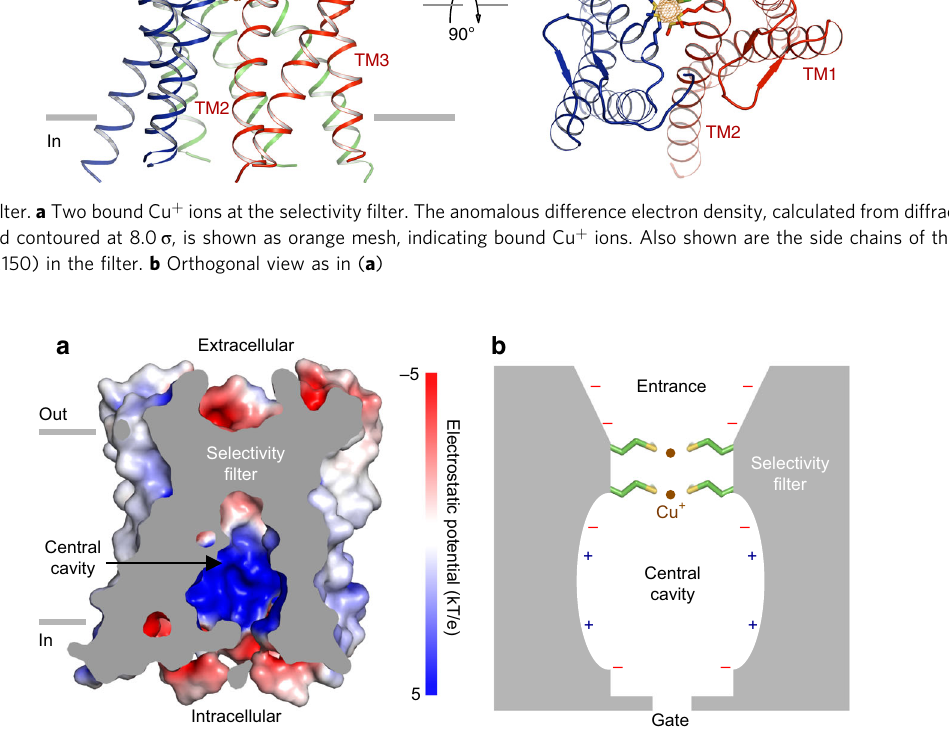
Fig. 5 Cu + permeation. a Cross-section view showing surface of the sCtr1 ion conduction pore colored by electrostatic potential (red, − 5 kT/e; white, neutral; blue, + 5 kT/e), with the relationship of the pore relative to the cell membrane shown. b Proposed mechanism of Ctr1 Cu + ion selectivity and permeation. Only two subunits are shown for clarity. Two methionine rings coordinate two Cu + ions. Electrostatic potential along the ion pore is indicated